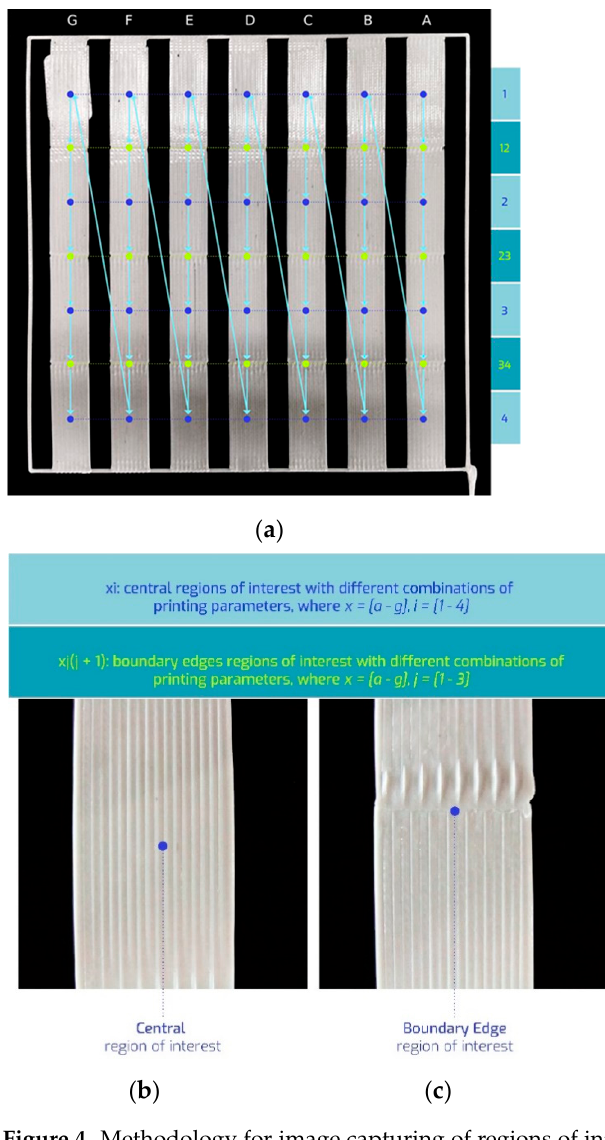
Figure 4. Methodology for image capturing of regions of interest: ( a ) overview of custom G-code motion and pauses; ( b ) central regions of interest; ( c ) boundary edge regions of interest.